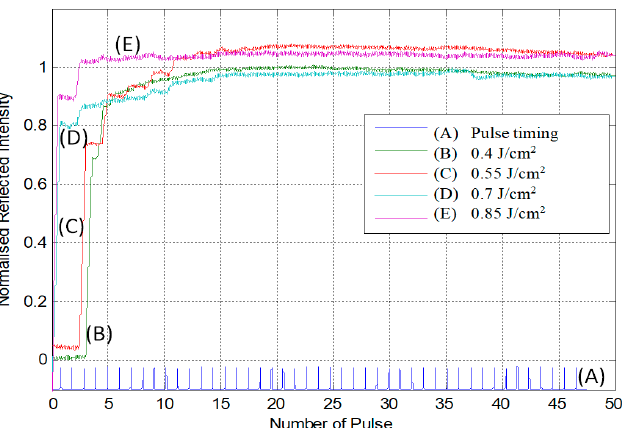
Figure 5. Effect of laser fluence on change in reflectivity of PBR with an increase in number of pulses for a stationary laser beam (beam size = 1 mm 2 , frequency = 10 Hz, monitoring laser wavelength = 635 nm).